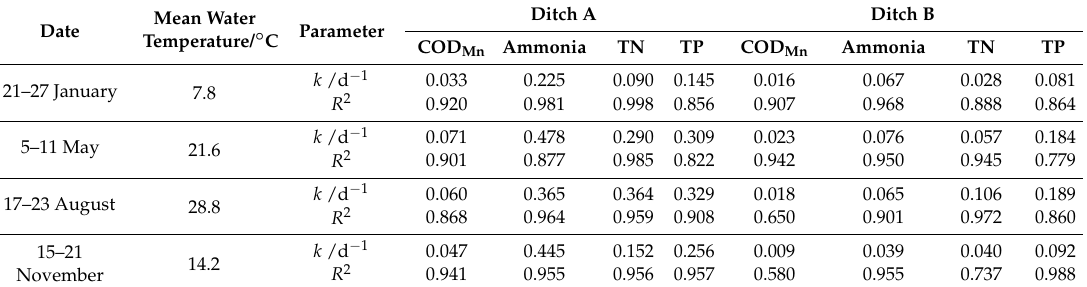
Table 3. The values of k and R 2 obtained from the first-order kernel model (the mean water temperature was calculated from a daily water temperature sample collected from each experimental